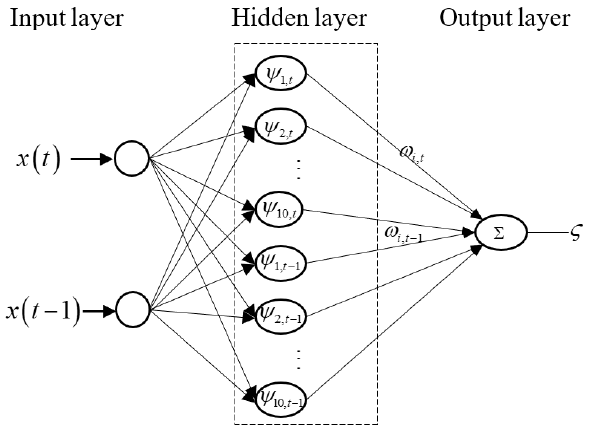
Figure 3. Structure of